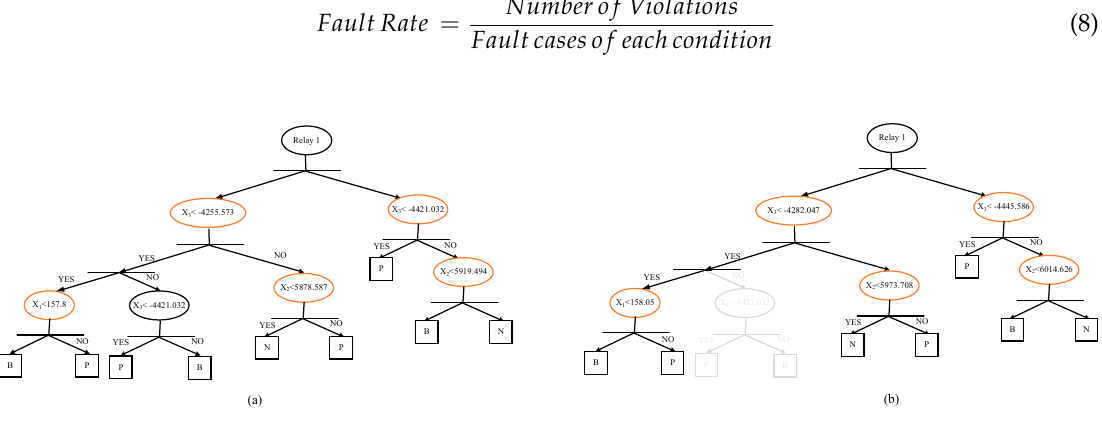
Figure 8. Relay 1 setting for: ( a ) base case and ( b ) test case.